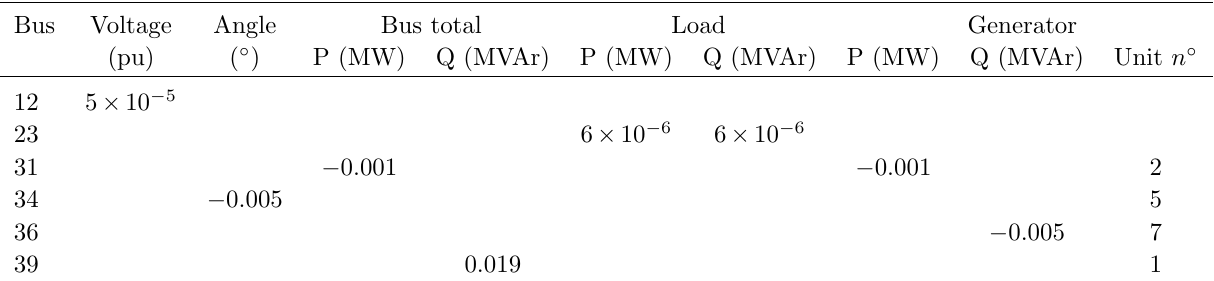
Table B.1. Maximum difference of load flow results between Matlab-IEEE-Benchmark and PowerFactory load flows for each physical value.